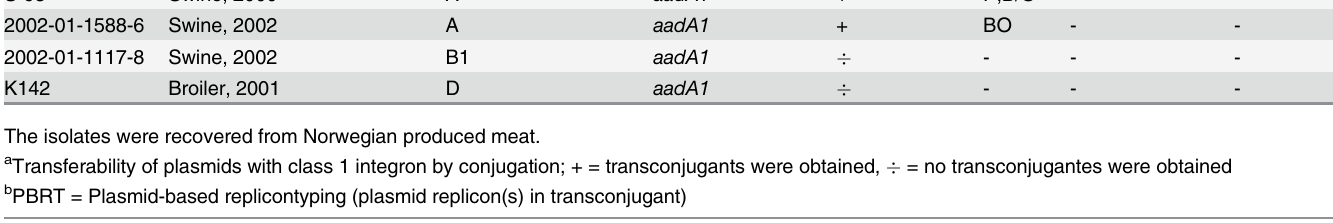
Table 6. Antimicrobial resistant Escherichia coli isolates containing class 1 integrons with an aadA1 cassette as the only inserted gene cassette. Isolate id